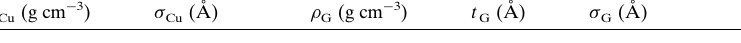
Table 2 Results of the fit of the XRR on liquid copper with the graphene layer. Parameters in bold were fixed during the fit. t G is the graphene layer thickness, (cid:9) Cu is the roughness of copper–graphene interface, (cid:9) G is the roughness of the graphene–gas interface; (cid:8) Cu is the liquid copper density, (cid:8) G is the graphene density, t S is the thickness of the graphene–copper separation gap. (cid:8) Cu (g cm (cid:3) 3